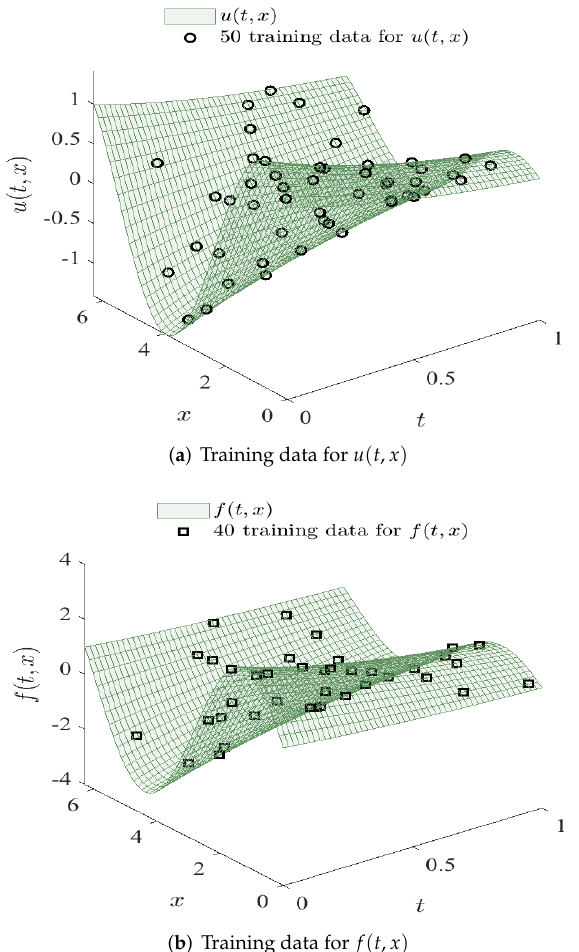
Figure 1. High-order partial differential equation: training data for u ( t , x ) and f ( t , x ) .